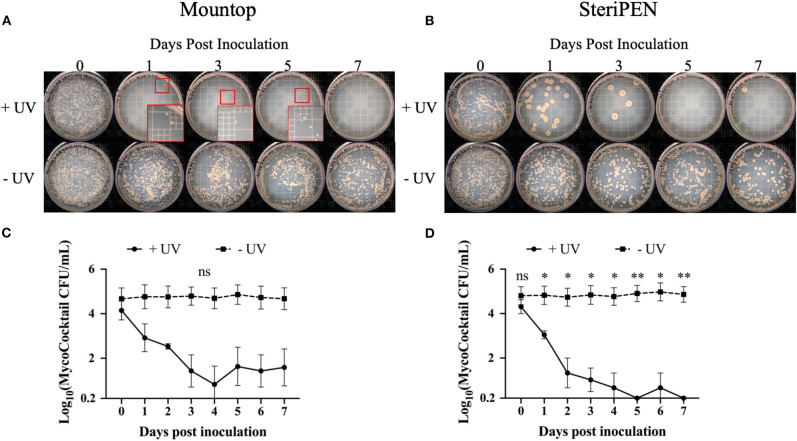
NTM CFU is reduced by UV-C treatment. Mountop (A,C) and SteriPEN (B,D) systems were inoculated with MycoCocktail and allowed to incubate at room temperature overnight. After incubation, the MycoCocktail was UV-C disinfected per the manufacturer's protocol. “+UV” = water that was UV treated. “-UV” = water that was not exposed to UV. One milliliter of suspension was removed and plated for CFU and the systems were returned to incubate at room temperature. CFU plating was repeated daily for 7 days post-inoculation. (A,B) Representative images of MycoCocktail CFU in Mountop and SteriPEN across 7 days of daily UV-C disinfection. Smaller red boxes indicate regions where growth was difficult to visualize. Larger red boxes show colonies magnified ~6-fold. (C,D) Log(MycoCocktail CFU) in SteriPEN and Mountop systems. n = 3 independent CFU measurements per timepoint. ns, not significant; significant at *p < 0.05, **p < 0.01.